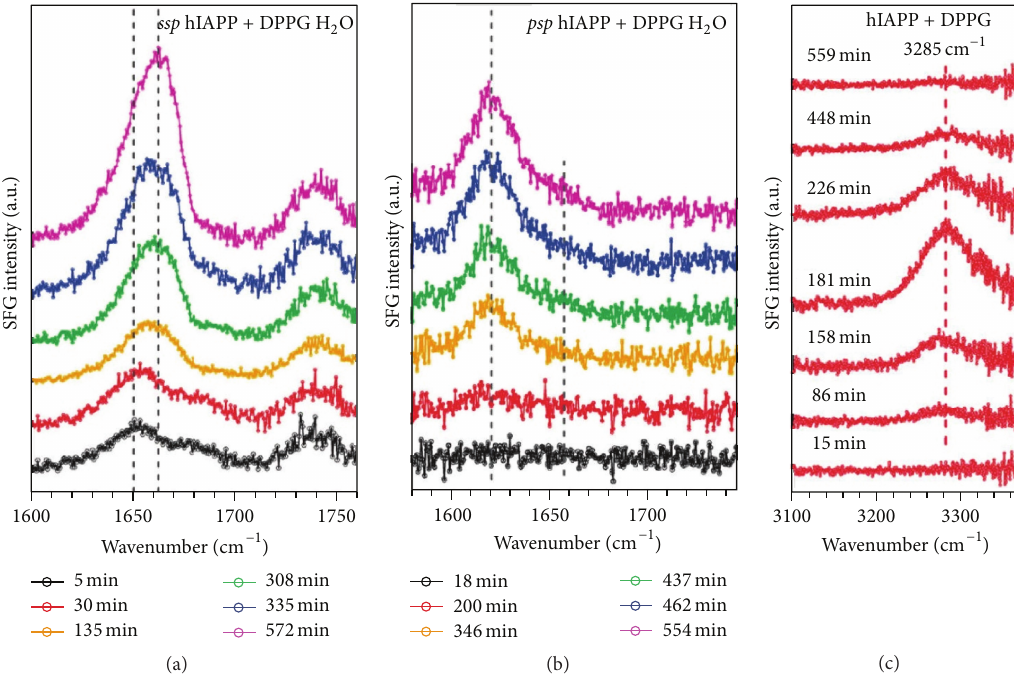
Figure 3: Kinetics of human IAPP aggregates at the lipid/H 2 O interface probed by time-dependent SFG spectra in the amide I region using (a) ssp (achiral) and (b) psp (chiral) polarization in the presence of DPPG and (c) in the N-H stretching region using psp (chiral) polarization in the presence of DPPG. Adapted from [61, 62] with permission. Copyright 2010 and 2011 American Chemical